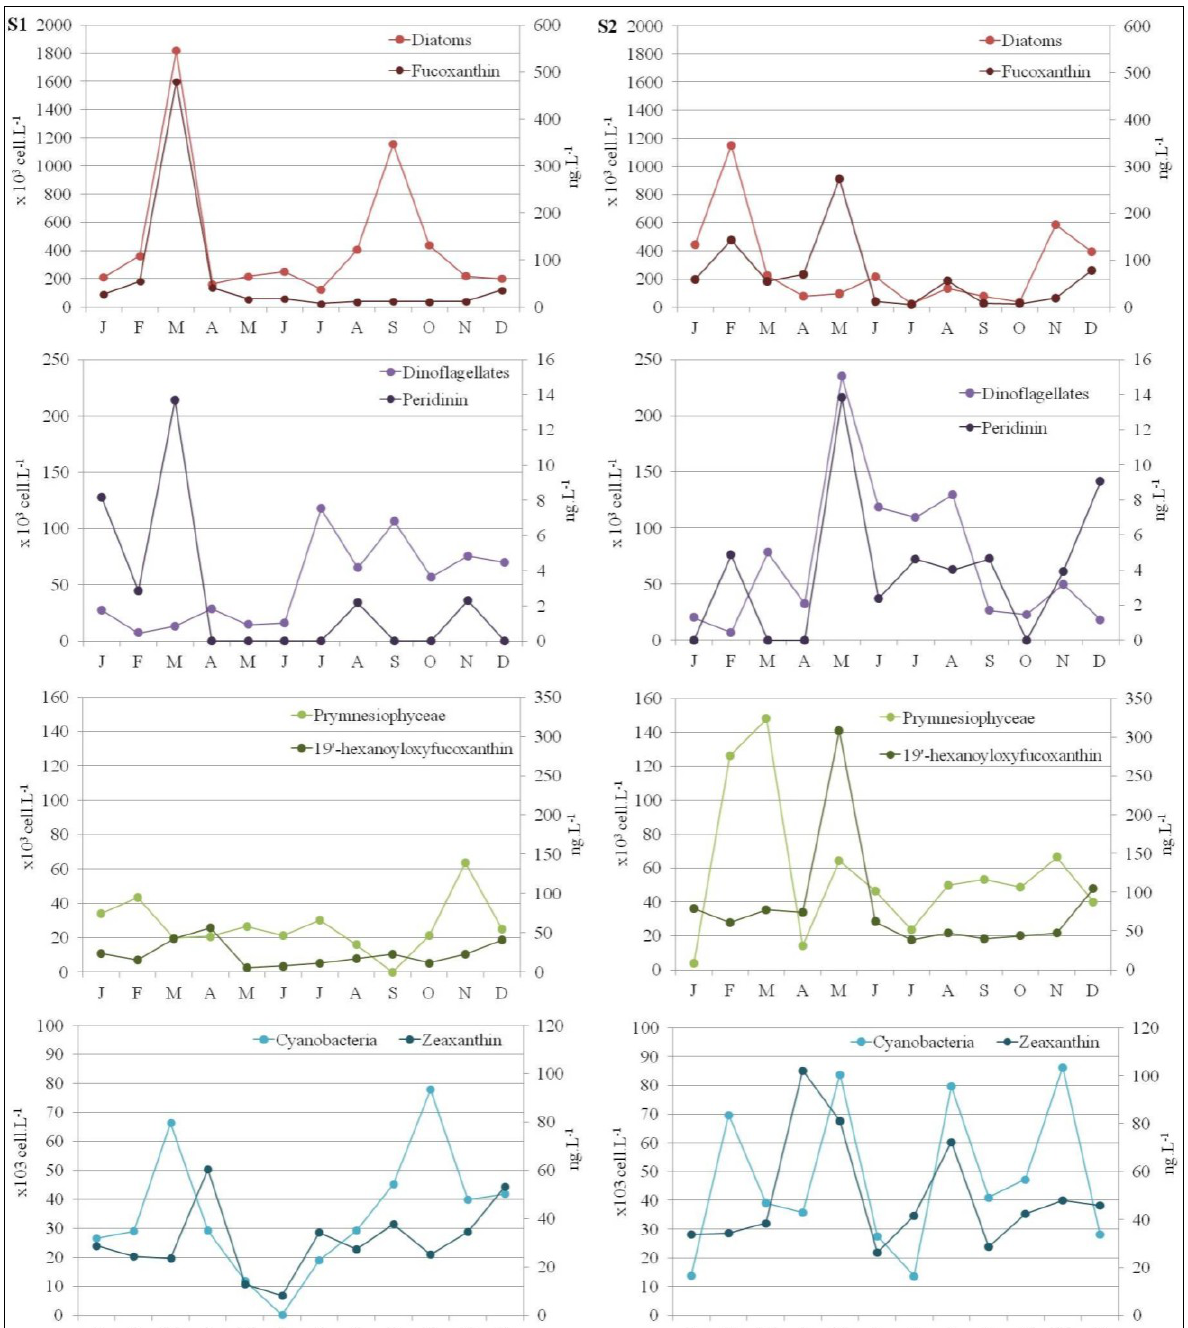
Figure 5. Spatio-temporal evolution of the principal classes of phytoplankton and the corresponding specific marker pigments at S1 and